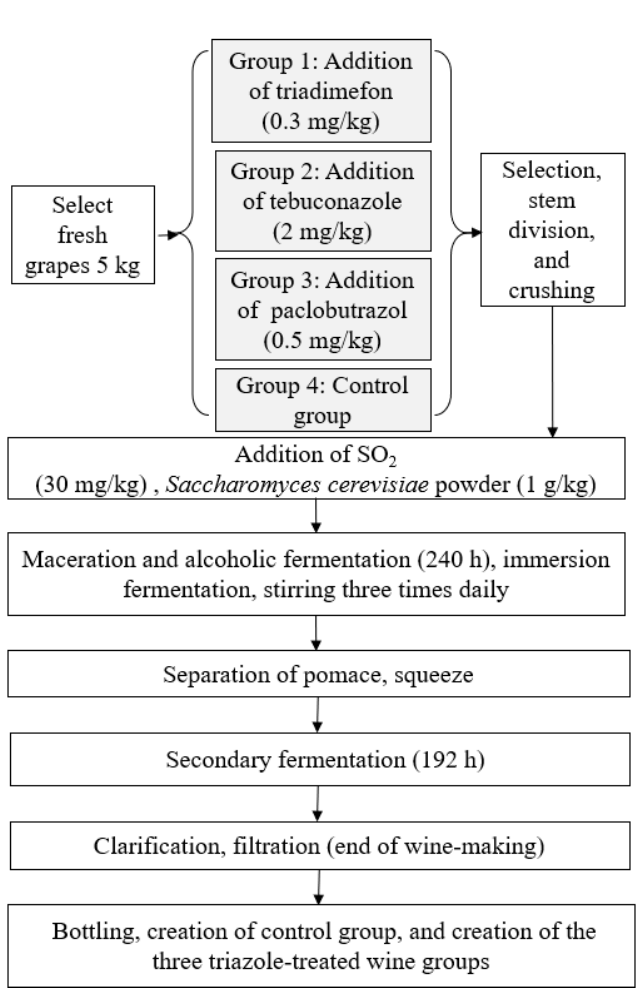
Figure 6. Wine making process adopted in the experiment.